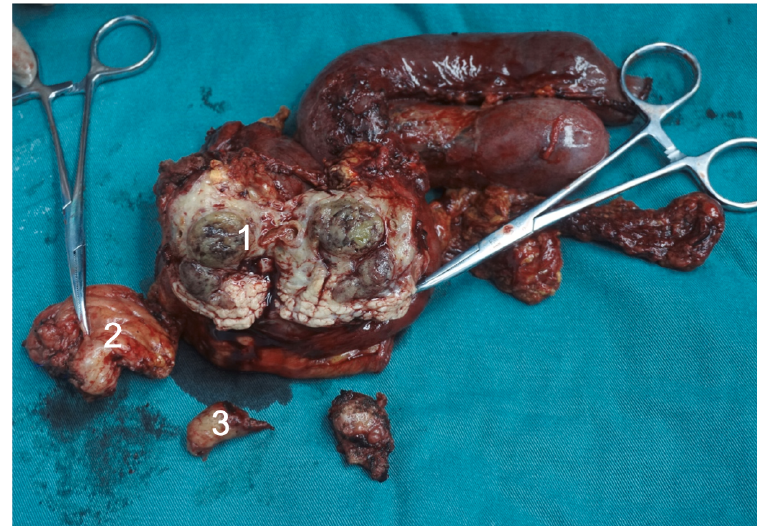
Figure 4. Extended pancreato-duodenectomy performed for a patient with rhabdoid pancreatic carcinoma at our center. ( 1 ) Tumor in the head of the pancreas. ( 2 ) Resected portion of the body of the pancreas to achieve negative margins. ( 3 ) Embolus from the main pancreatic duct.